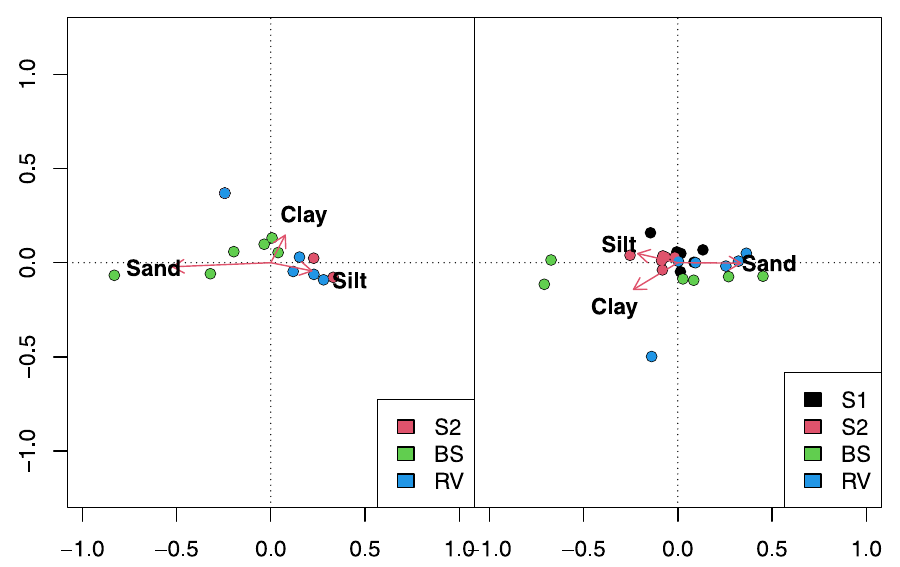
Fig 8. Principal component analysis of the particle size of sediments from runoff erosion in 2019 (on the left) and 2020 (on the right) with different vegetation types (S1 = Schedonorus arundinaceus blend, S2 = Lolium perenne , RV = resident vegetation) and bare soil